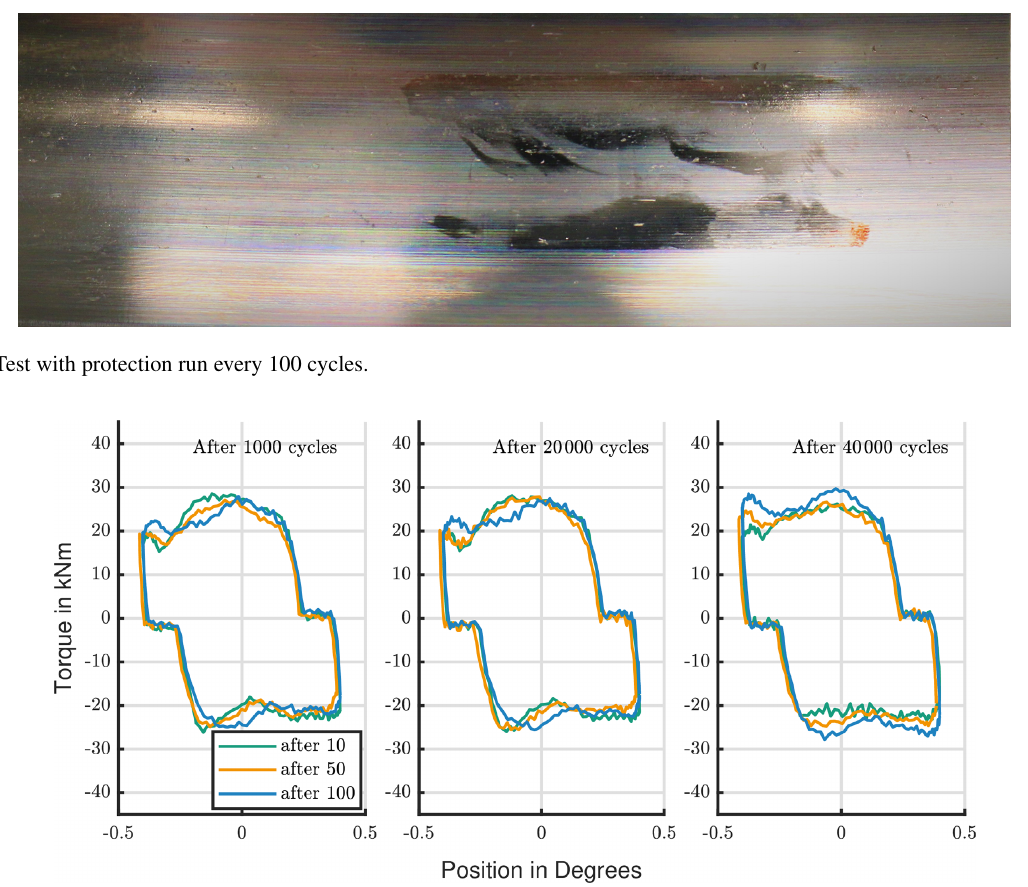
Figure 14. Torque development: comparison of protection runs with different frequencies of occurrence.